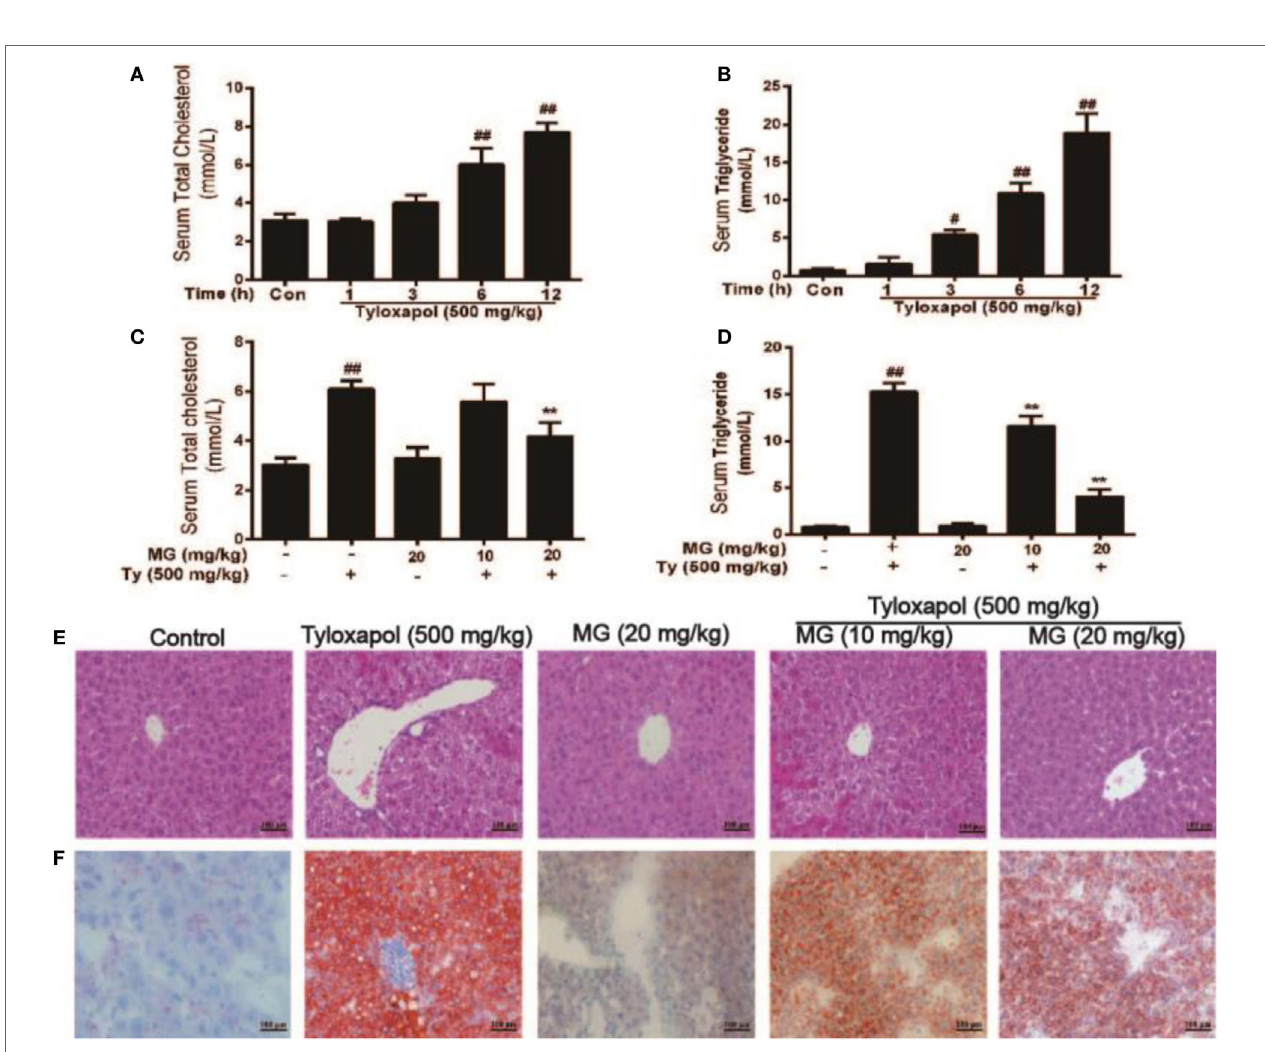
FigUre 7 | Effect of magnolol (MG) on oleic acid (OA)-activation of mitogen-activated protein kinase protein expression in HepG2 cells. Cells were incubated with MG (4 µg/mL) in the presence or absence of OA (120 µM) for 24 h. (a) Protein expression levels of P-P38, P38, P-c-Jun N-terminal kinase (JNK), JNK, P-extracellular regulated protein kinase (ERK), and ERK were measured by western blot analysis. (B–D) Quantification of the relative protein expression of P-P38/ P38, P-JNK/JNK, and P-ERK/ERK was determined by photodensitometry. (e) SP600125, U0126, and SB203580 (inhibitors of JNK, ERK, and P38, respectively) were added to plates of cultured cells at 30 min or 1 h for protein inhibition and then mixed with OA (120 µM) for an additional 24 h. Protein expression levels of P-P65 and P65 were checked by western blot. (F) Quantification of the relative expression of P-P65/P65 was revealed by density analysis. The fold induction results were acquired from three independent experiments and presented as the mean ± SD. Statistically significant at ## p < 0.01 vs. the control group and * p < 0.05 and ** p < 0.01 vs. the OA-treated group (one-way ANOVA followed by Tukey’s